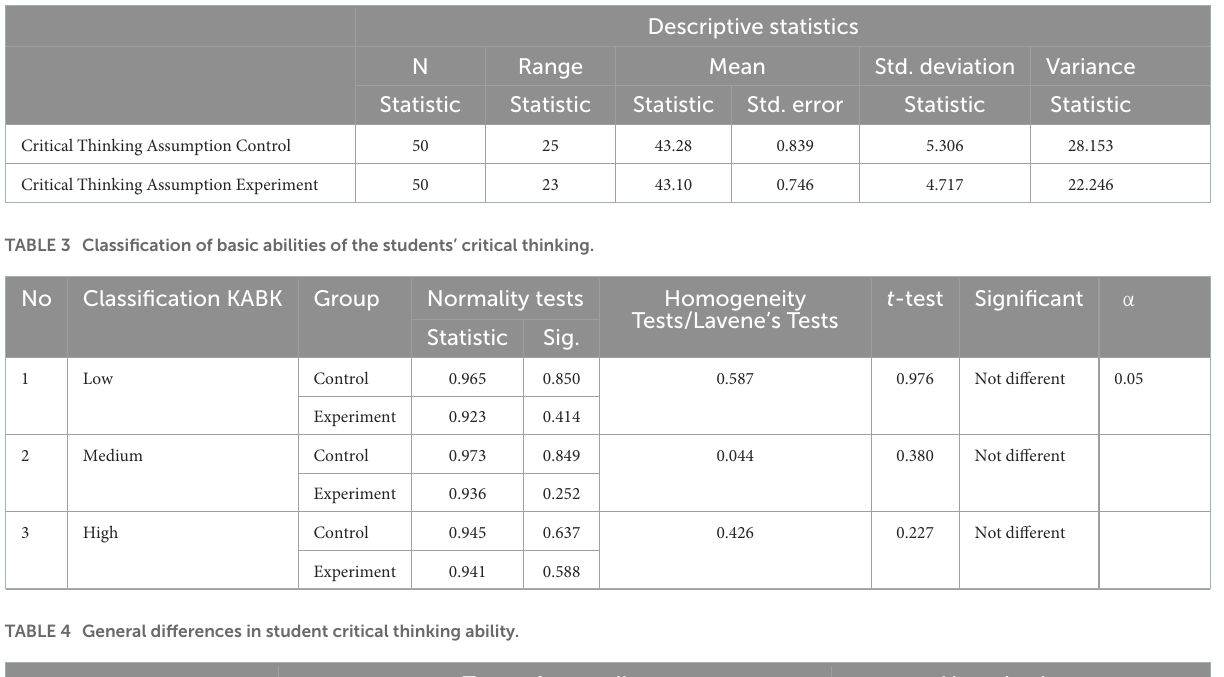
TABLE 2 Abilities of students thinking critically.